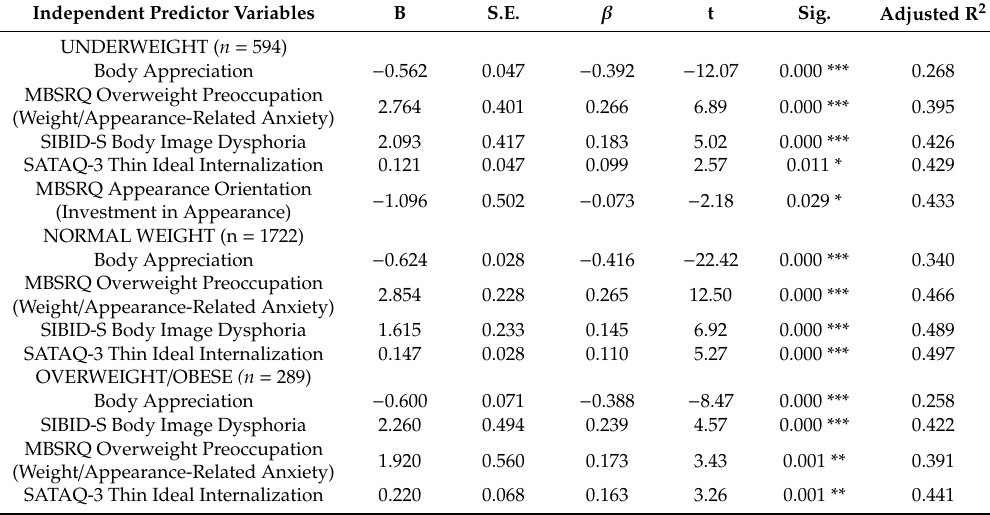
Table 2. Summary of multiple regression of BMI categories predicting disordered